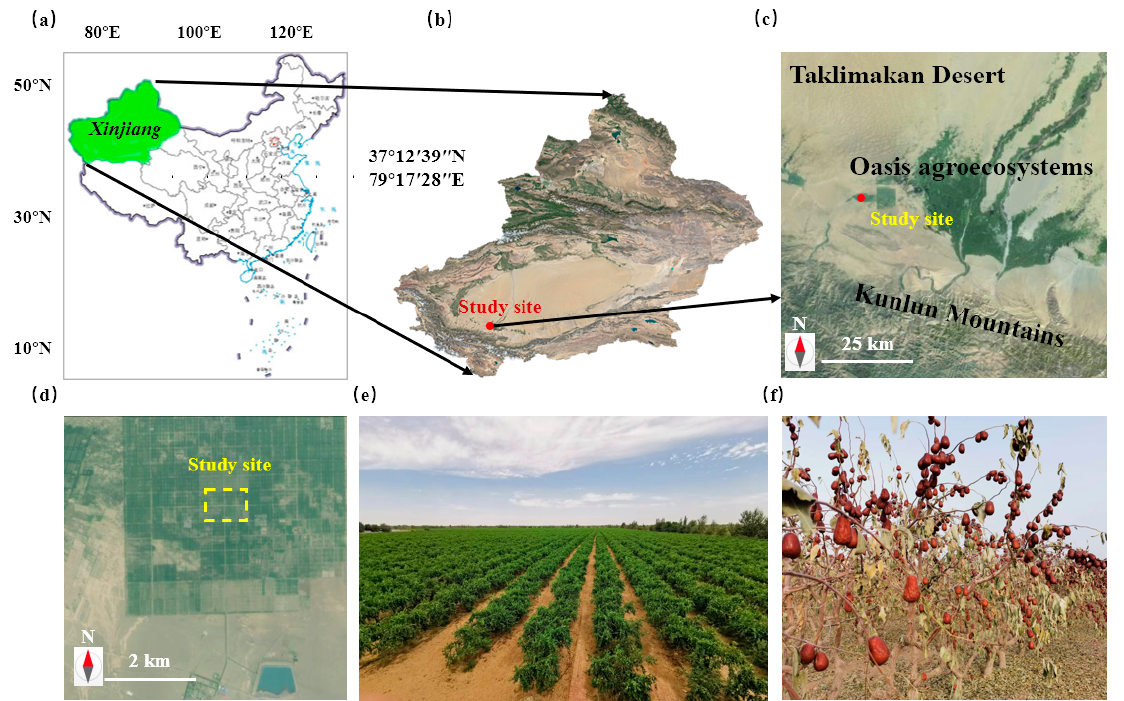
Figure 1. Maps and imagery of the study site. Xinjiang is located in the northwest of China ( a ) and is characterized by an extremely arid desert climate ( b ). High levels of agricultural irrigation are required for the oasis agroecosystems in Xinjiang ( c ). Field experiments were conducted at the Irrigation Test Station of Pimo Reclamation Area (37°12 ′ N, 79°17 ′ E) in Kunyu City, Xinjiang ( d – f ). The soil at this site is sandy loam with a pH of 7.88. The depth of groundwater is about 3.0 m, and the maximum depth of frozen soil is 0.67 m. Due to strong evaporation, the problem of soil salinization in this area is serious. The meteorological data during the growth period of jujube is shown in Figure 2. Within the 0–40 cm topsoil, the organic matter, total N, and available P and K are 4.23 g kg − 1 , 4.82 mg kg − 1 , 17.61 mg kg − 1 , and 84.52 mg kg − 1 , respectively. The physical characteristics of the soil (dry bulk density and field water holding capacity) in different soil layers (0–140 cm) are shown in Table